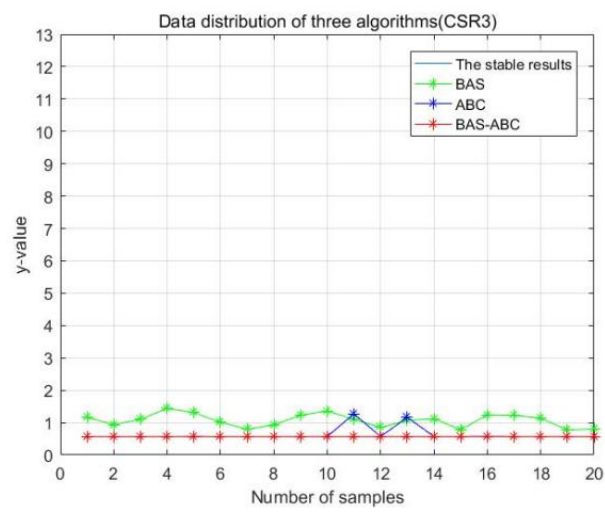
Figure 17. Data distribution-20 of three algorithms (CSR3).